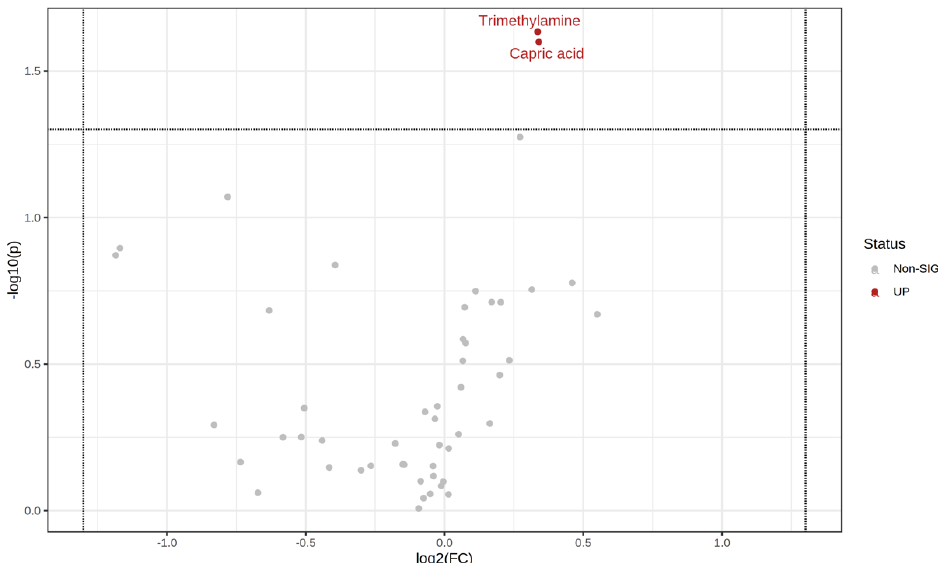
Figure 5. Volcano plot: Probiotics group longitudinal pairwise comparisons of time point t 0 and t 2 in stool. The log 2 fold change (log2 FC) ( x -axis) is plotted against the corresponding adjusted p -value ( y -axis). Thresholds for significance (adjusted p -value = 0.05; horizontal dashed line) and changes in concentration, vertical dashed lines, are shown. Significantly increased metabolites in the probiotics group ( n = 28) are displayed as red dots after 4 weeks compared to the beginning. Insignificantly altered metabolites are shown as gray dots.